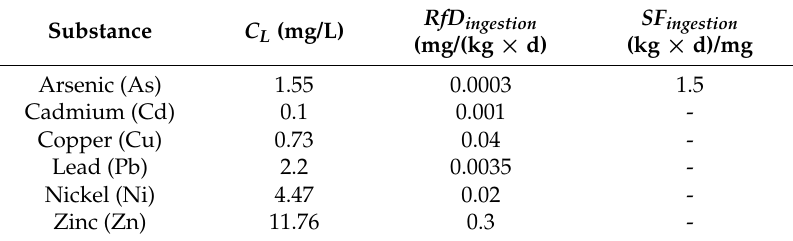
Table 3. Baseline characteristics of the contaminants used in the